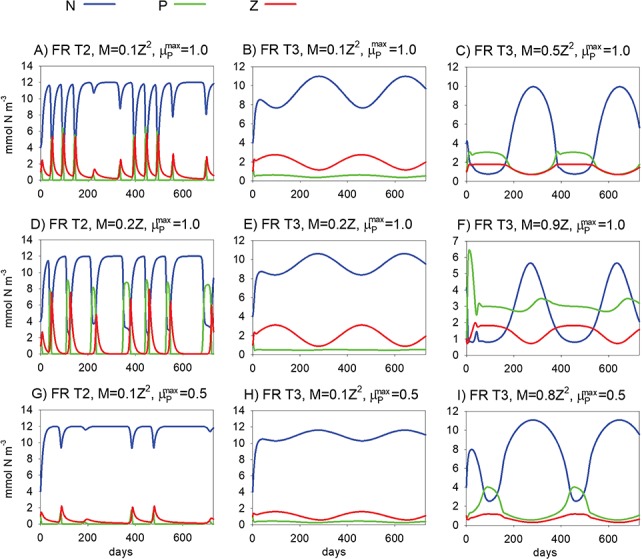
Model simulations examining sensitivity to functional response (FR, Type 2 or 3), the functional form of mortality (M: Linear and Quadratic), mortality rate (parameter mZ) and maximum phytoplankton growth rate \documentclass[12pt]{minimal}
\usepackage{amsmath}
\usepackage{wasysym}
\usepackage{amsfonts}
\usepackage{amssymb}
\usepackage{amsbsy}
\usepackage{upgreek}
\usepackage{mathrsfs}
\setlength{\oddsidemargin}{-69pt}
\begin{document}
}{}$\Big({\mu}_P^{max}\Big)$\end{document}. Base parameter values as for the run shown in Fig. 3, except ΓP = 1, Ndeep = 12 mmol N m−3 and Ω = 365 days.